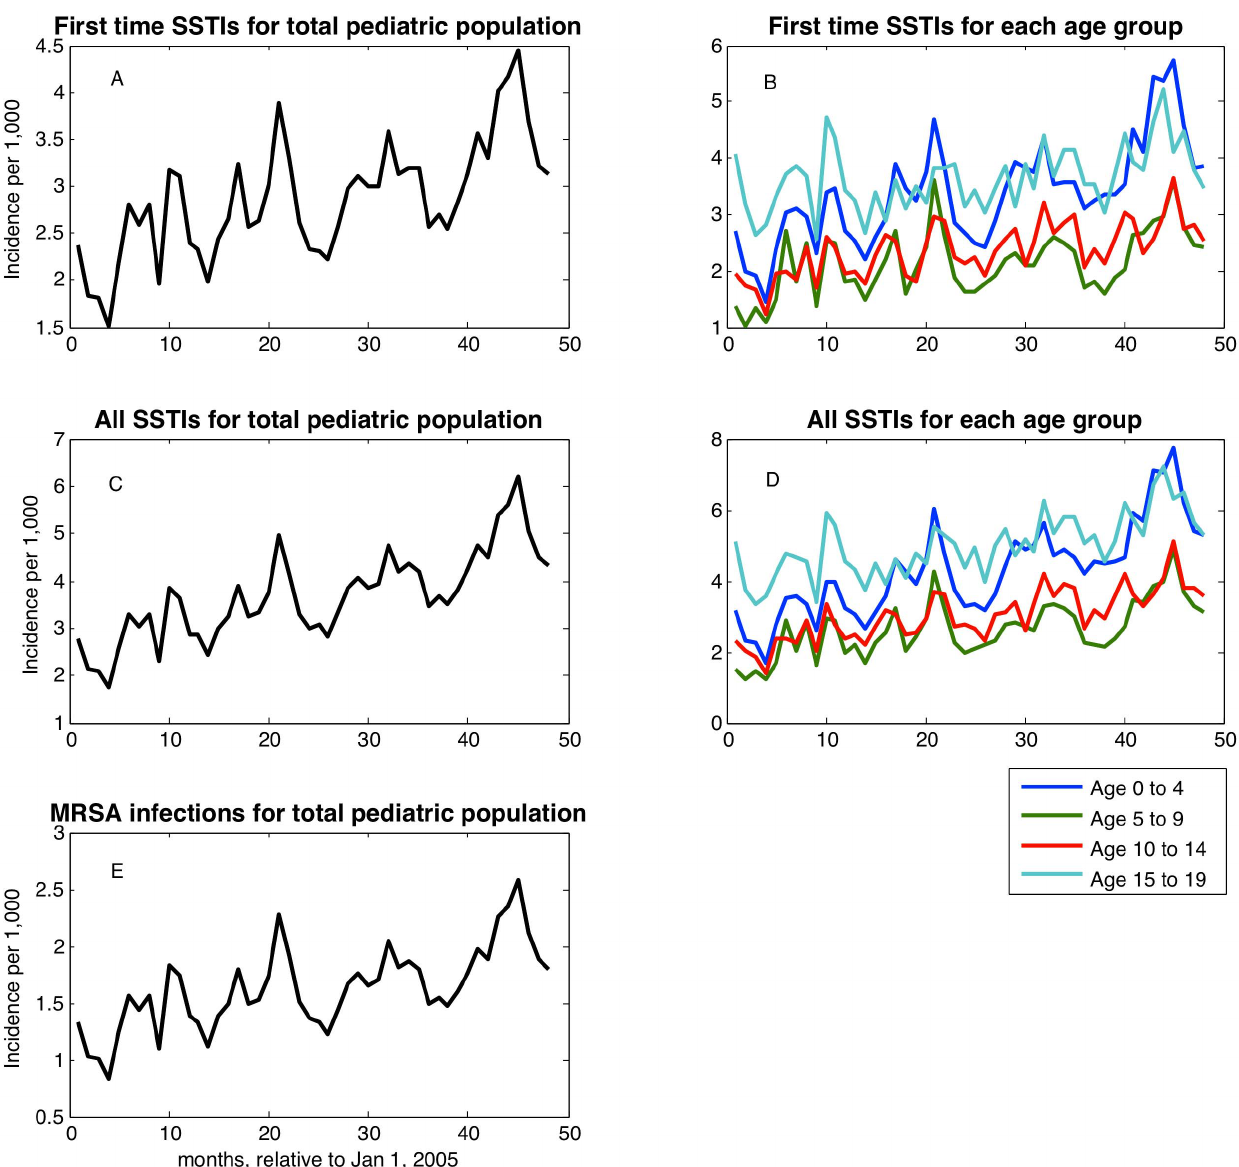
Figure 1. Time series of incidence of general SSTIs in total pediatric population and four pediatric age groups: first time (A and B); sum of first time and recurrent (C, D); incidence of first time and recurrent MRSA-related SSTIs in total pediatric population (E)